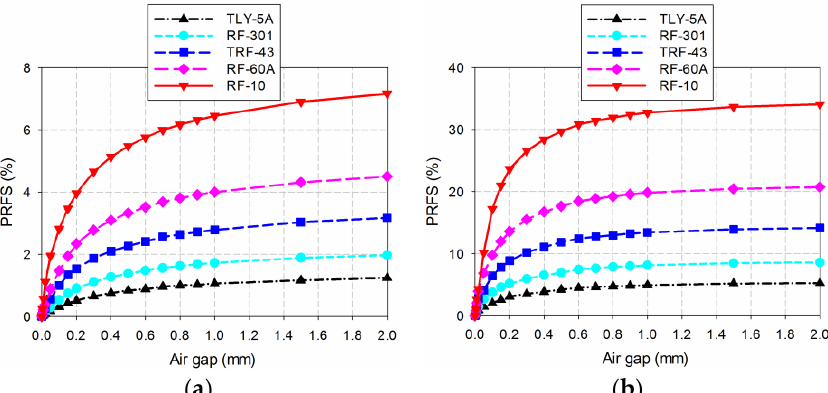
Figure 15. Variations on the resonant frequency of the conventional and proposed patch antennas when varying the air gap: ( a ) Conventional f r1 ; ( b ) proposed f r1 .